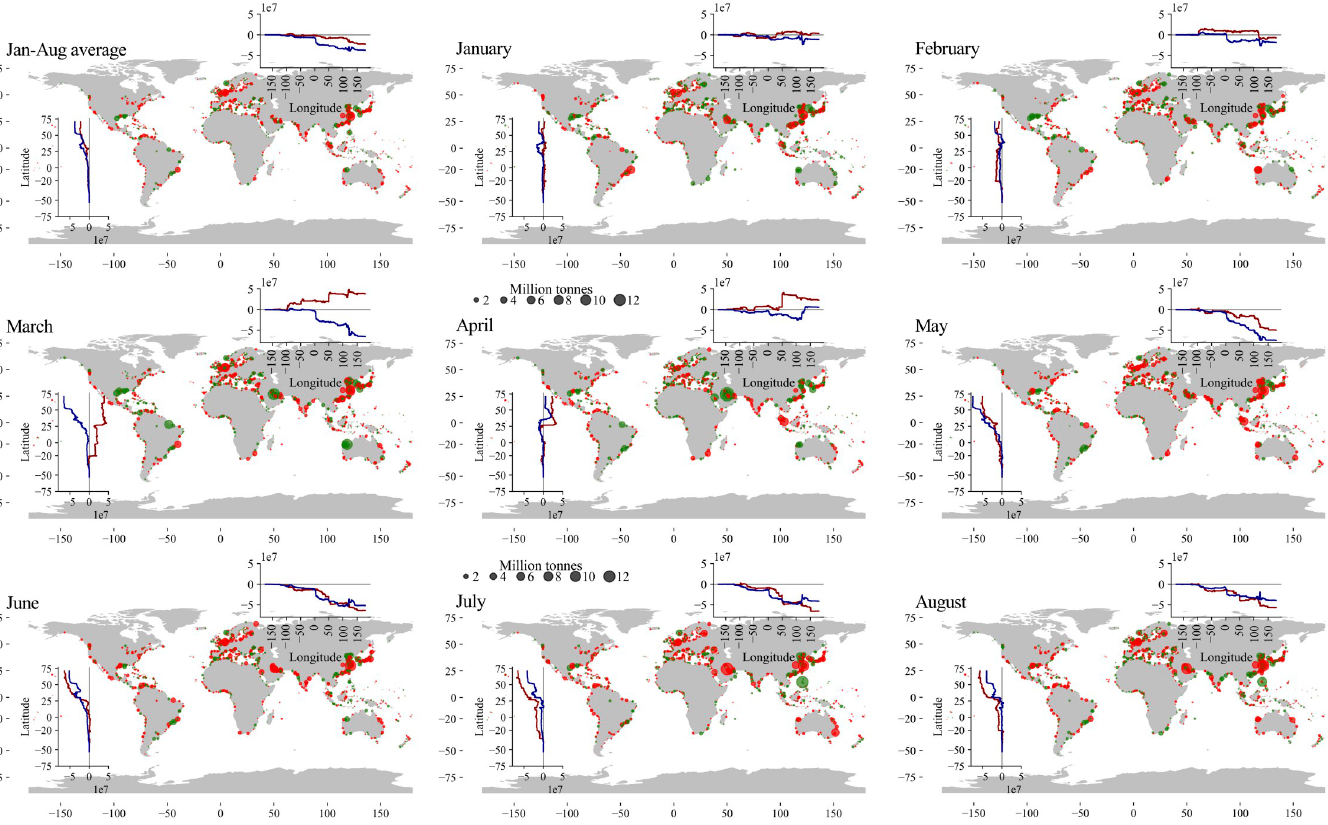
Fig 1. Port-level trade losses over time. The geographical location and magnitude of trade losses for Jan-Aug 2020 compared to 2019, including the average over the eight months and the losses per month. Green = positive change, red = negative change. The subplots show the cumulative change over latitude and longitude for imports (dark blue) and exports (dark red). This figure was generated using the ‘Geopandas’ package (https://geopandas.org) and Python Programming Language (version 3.7). The underlying basemap is derived from ‘Natural Earth’ global vector data (https://www.naturalearthdata.com).